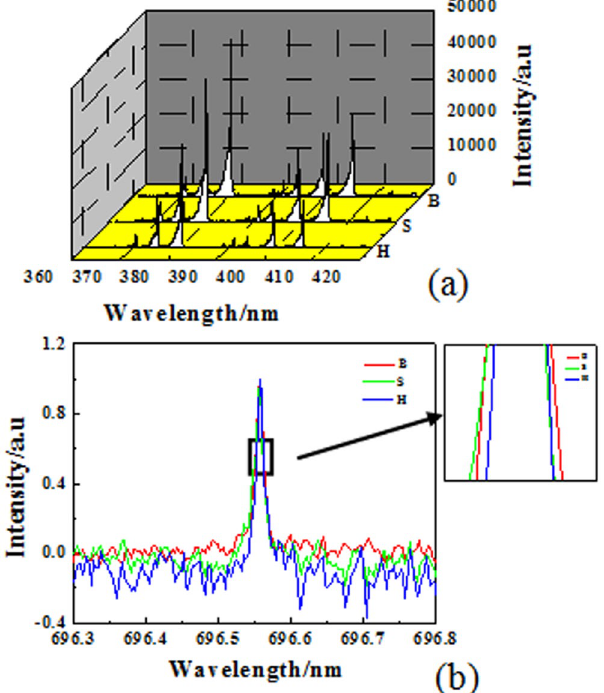
Figure 5. ( a ) Spectrum lines of the broadenings of N 2 second positive band system ( C 3 П u → B 3 П g ) at different positions. ( b ) The profiles of the spectral line 696.5 nm of the three discharges